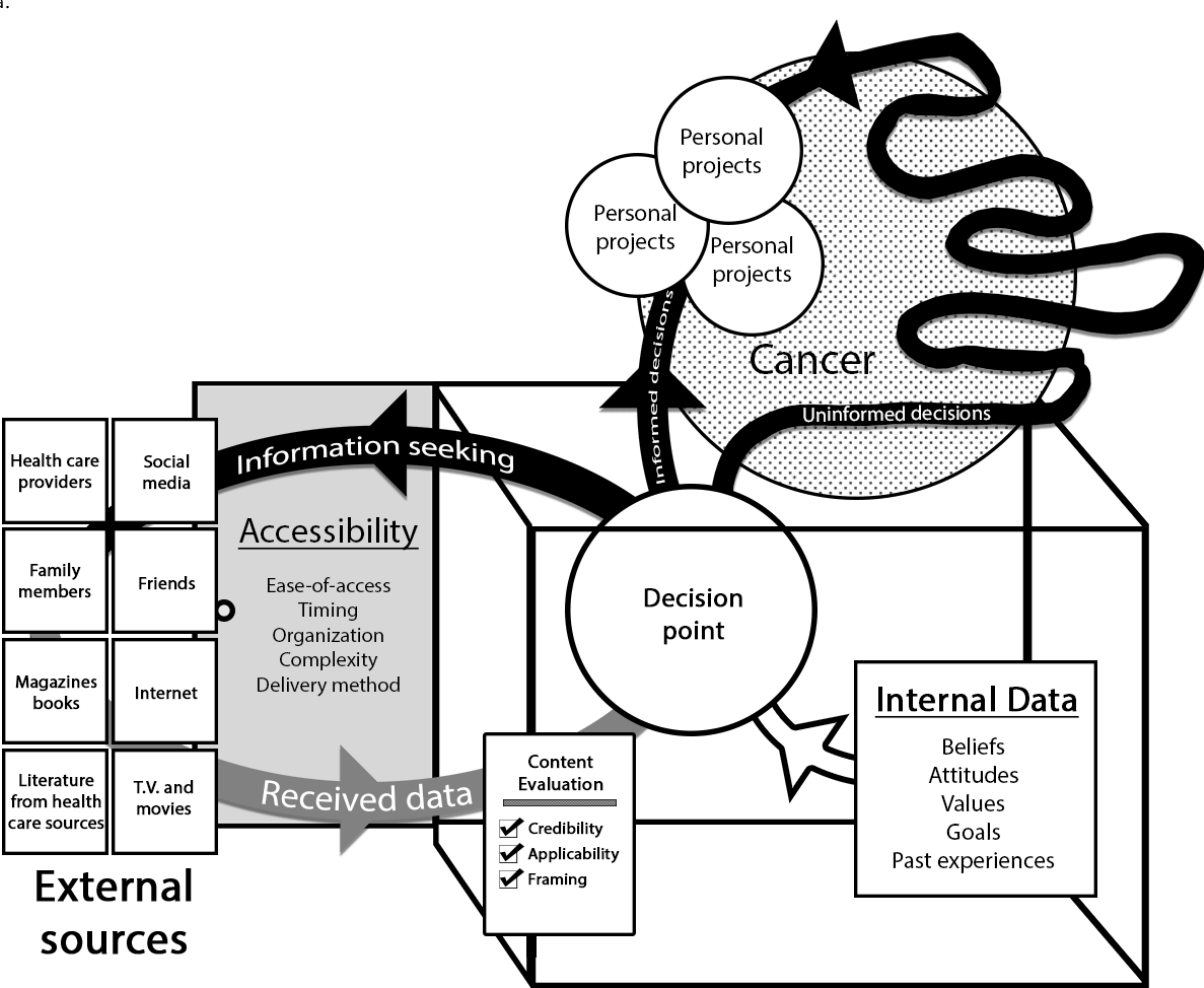
a resulting lack of certainty about what to expect, both in terms of the cancer itself and how the consequences of cancer, such as treatment and altered life expectancy, will affect their personal projects. Information is understood as a process involving receiving data about cancer and interpreting it to increase the certainty of the outcome of different actions. High quality data, defined as data that is accessible, credible, applicable, and positively framed, enhances decision-making support and results in improved engagement with personal projects. The dark black arrowed lines represent aspects of the information/action continuum in which energy and time is diverted between personal projects and seeking information. The indirect winding line titled “uninformed decisions” illustrates the inefficient use of an individual’s finite energy and time when decisions are not informed by high-quality cancer